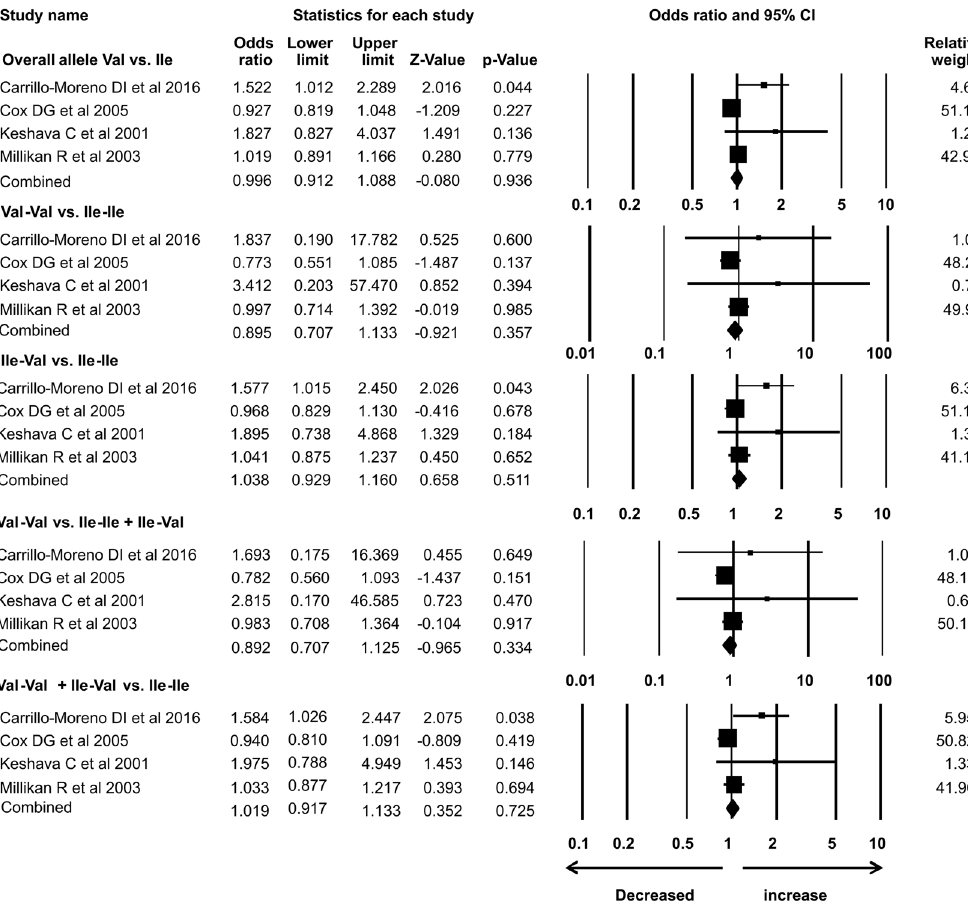
Figure 8. Forest plot: Her2 Ile 655 Val (rs1136201) gene polymorphism data from American ethnic group showing OR and 95% CI for analyzing its association with breast cancer risk. Squares represents OR and horizontal line represents 95% Confidence Interval (CI) of odds ratio (OR).